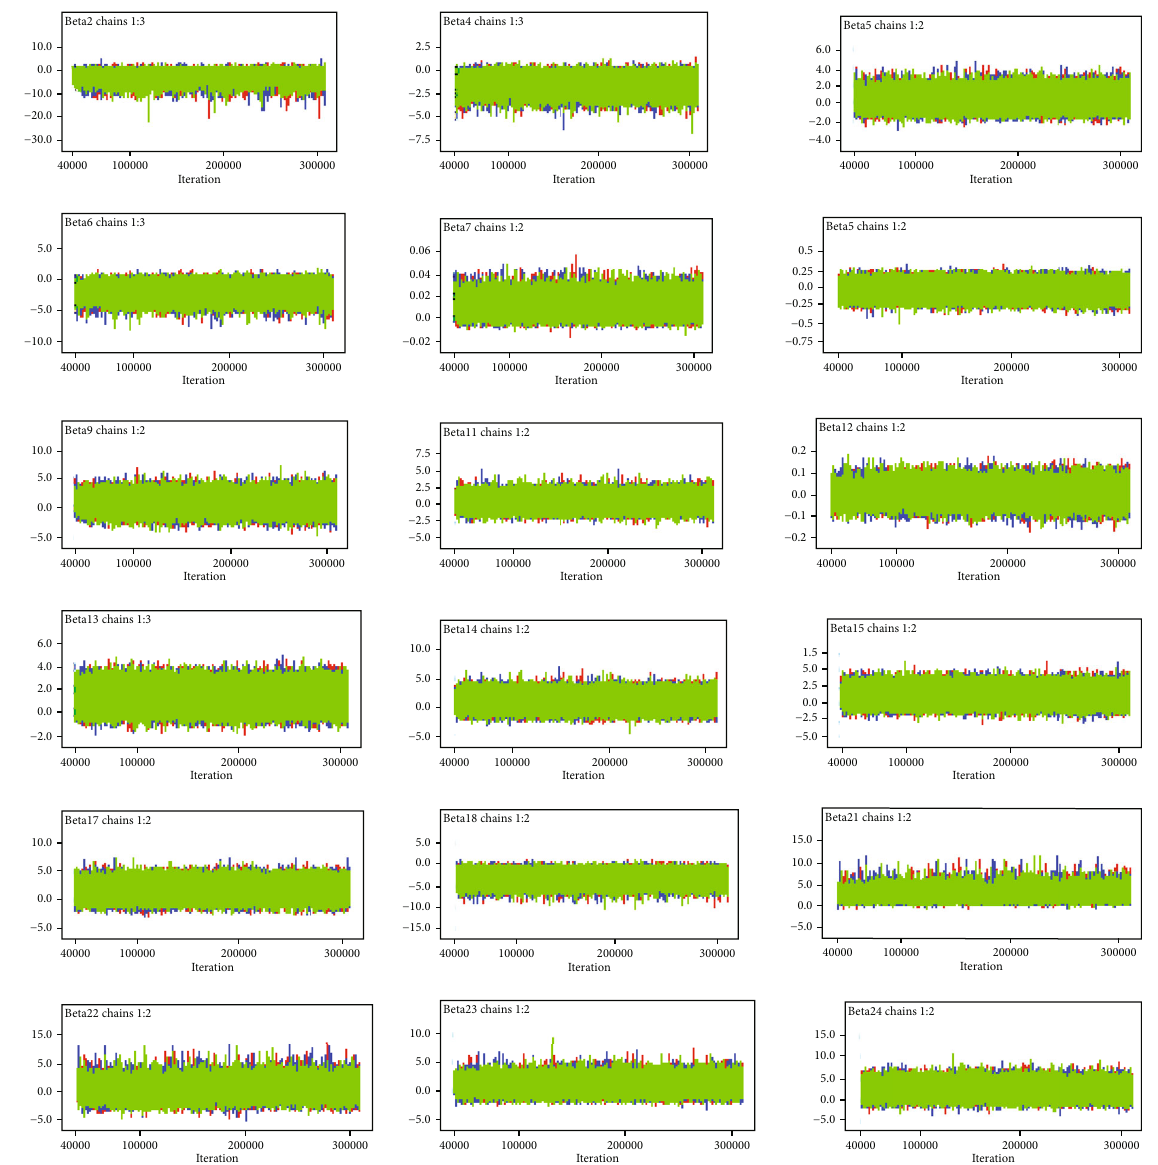
Figure 1: Time series for convergence of coe ffi cients for the